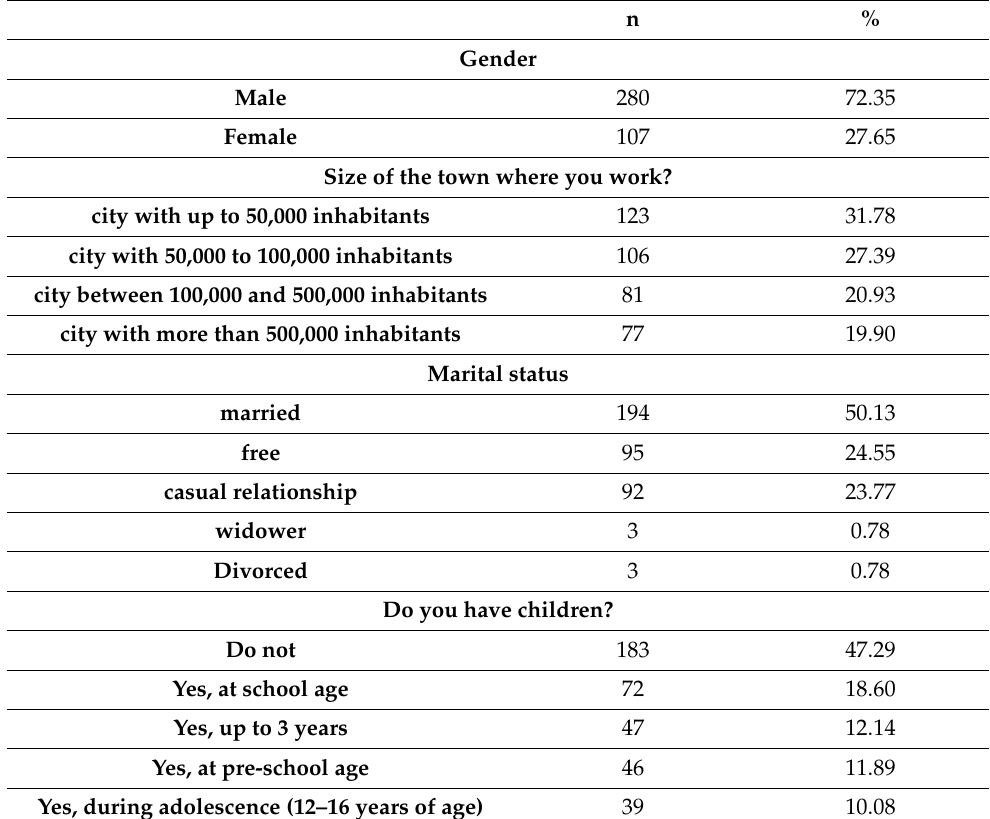
Table 1. Sociodemographic characteristics of the study